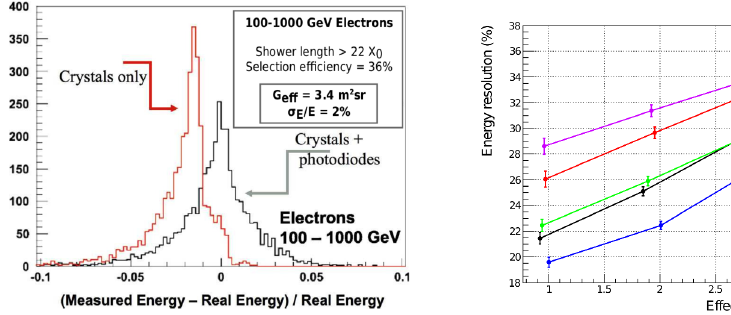
Figure 1. Left: fraction of energy deposited in the calorimeter by electrons from 100 GeV to 1 TeV, taking into account the energy deposited in crystals only (red histogram) or also the contribution of direct ionization on photodiodes (black histogram). Right: energy resolution for protons at 1 TeV by employing di ff erent materials and di ff erent event selections, corresponding to e ff ective